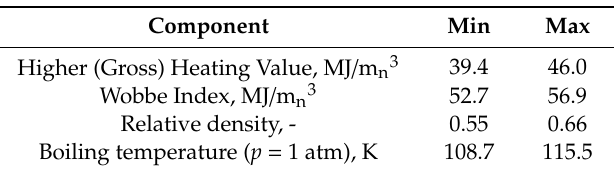
Table 2. Typical quality parameters limits of liquefied natural gas based on various sources and calculated from various available LNG compositions (own calculations).